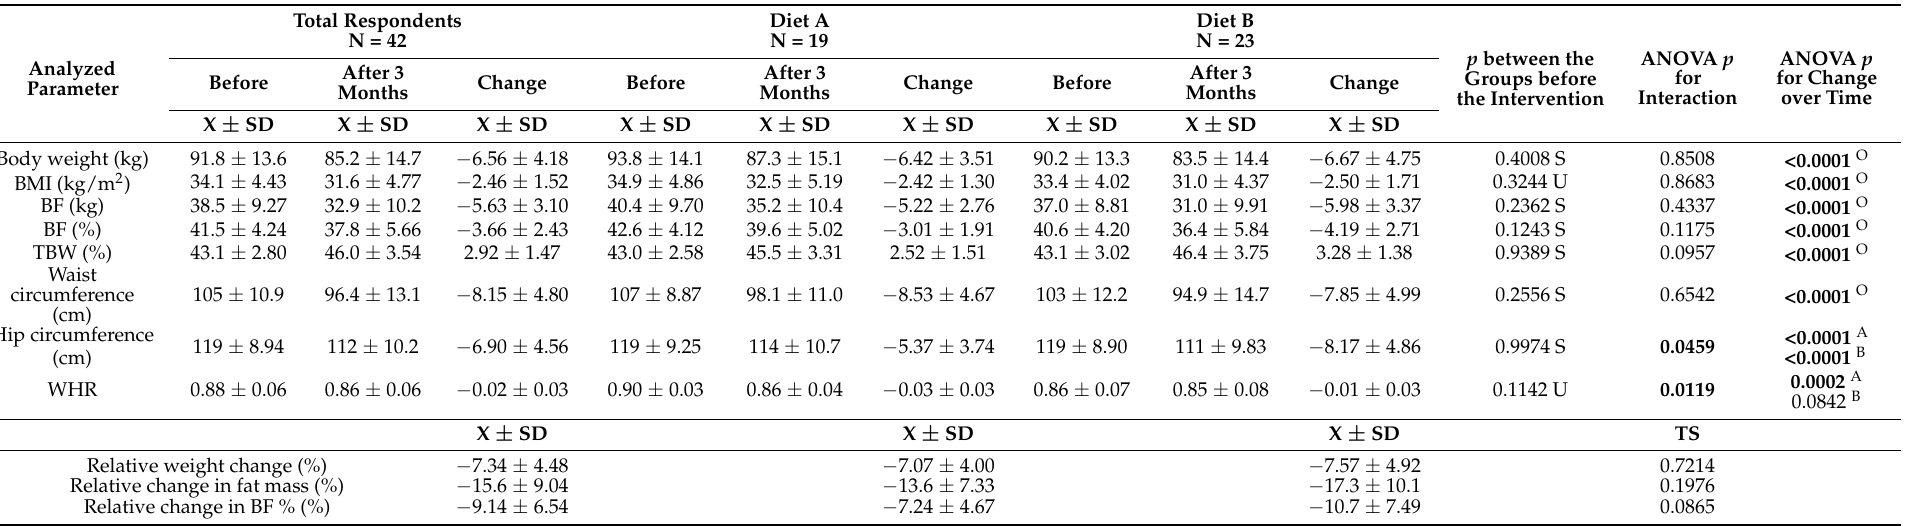
Table 3. Anthropometric parameters of study participants before and after 3 months of diet